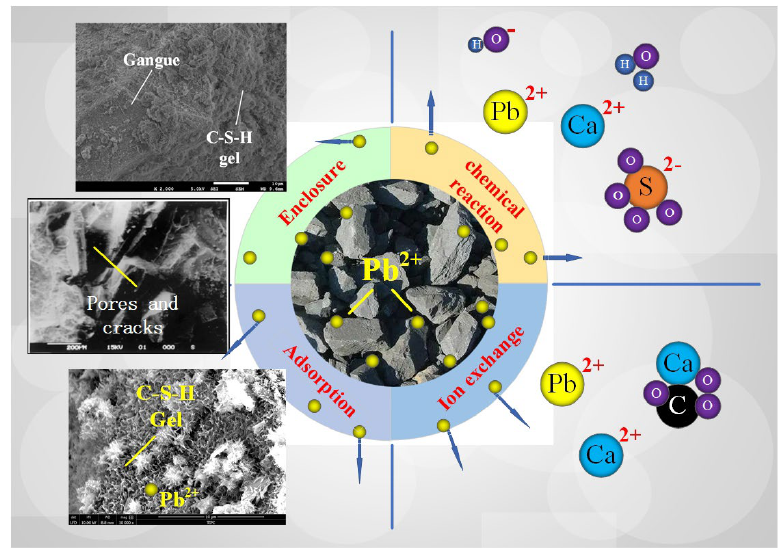
Figure 13. Pb 2+ consolidation mechanism of gangue based cemented backfill.